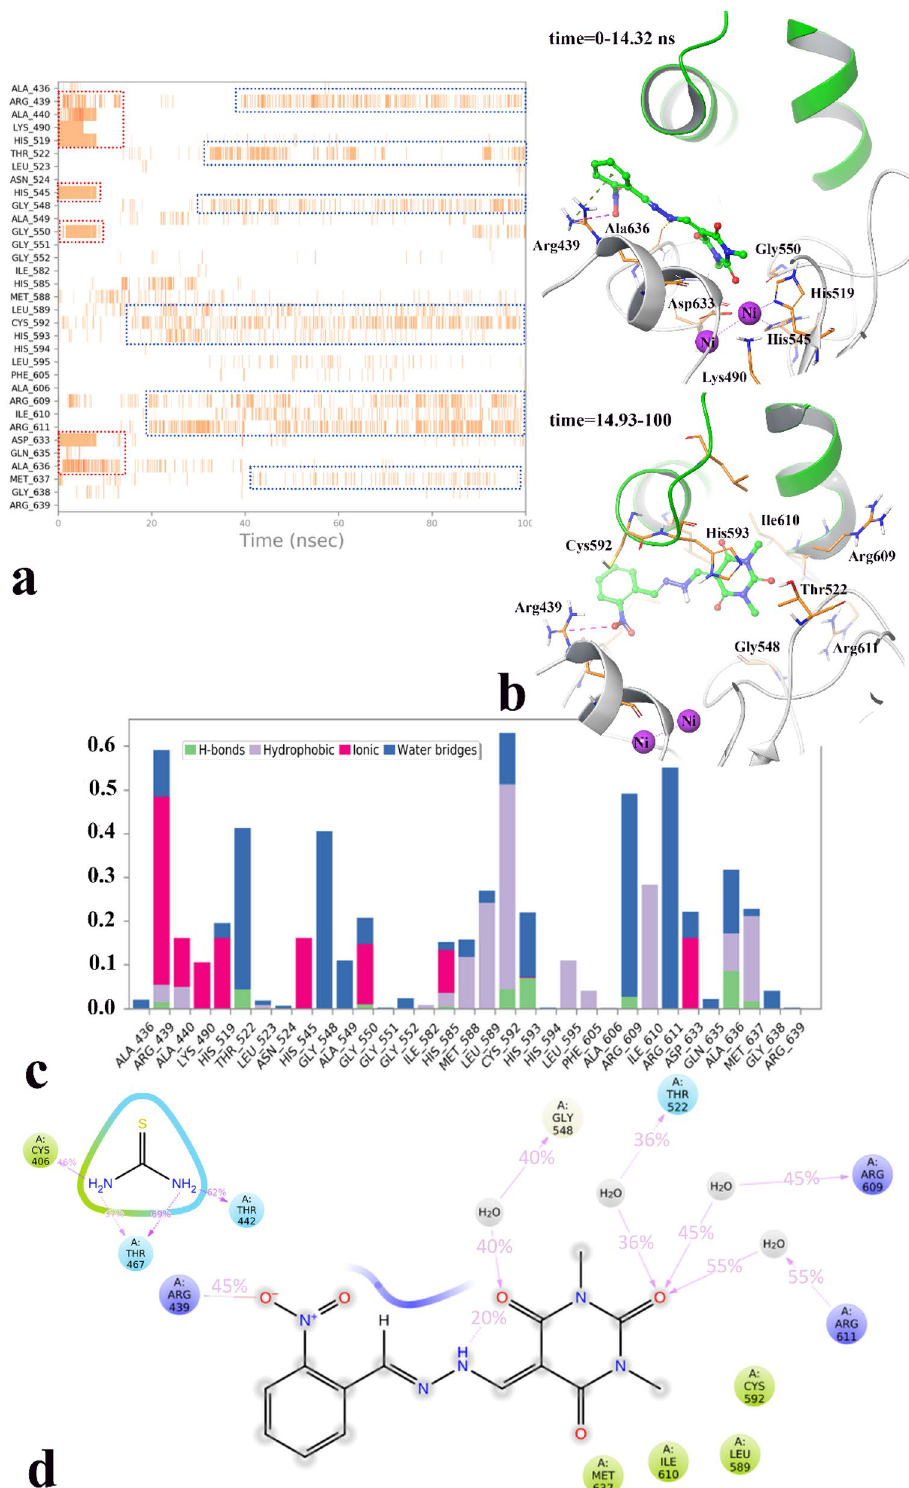
Figure 10. The timeline representation of the interactions shows the residues interact with compound 7h in each trajectory frame (more than one specific contact with the ligand is represented by a darker shade of orange) ( a ). The 3D representation of urease in bound-state with compound 7h in two different orientations related to 0–14.32 ns and 14.32 to the rest of simulation time (active site flap are depicted in green cartoon mode) ( b ). The simulation interactions diagram panel. The stacked bar charts are normalized over the course of the trajectory: some protein residues may make multiple contacts with the ligand ( c ). 2D representation of ligand-residue interactions that occur at least 30% of simulation time of urease bound-state of thiurea and compound 7h ( d ). The molecular graphic in this figure was generated using VMD